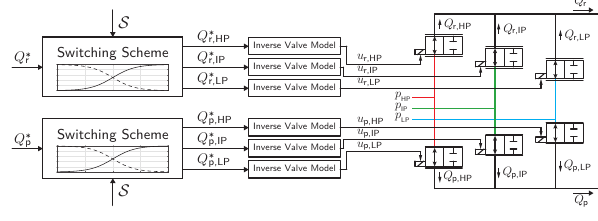
Figure 13: Structure used to divide the flow